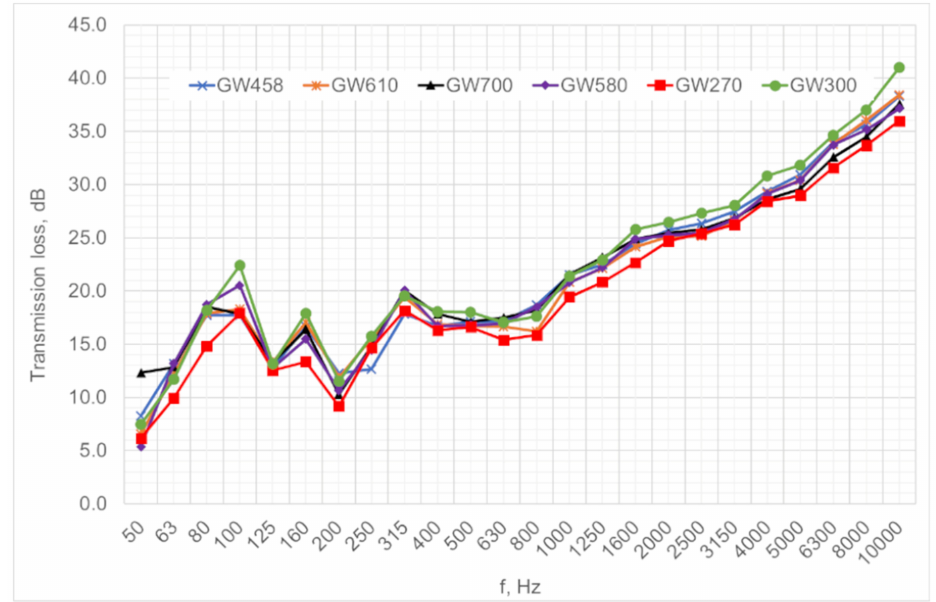
Figure 5. Measured transmission loss (TL) of studied PVC